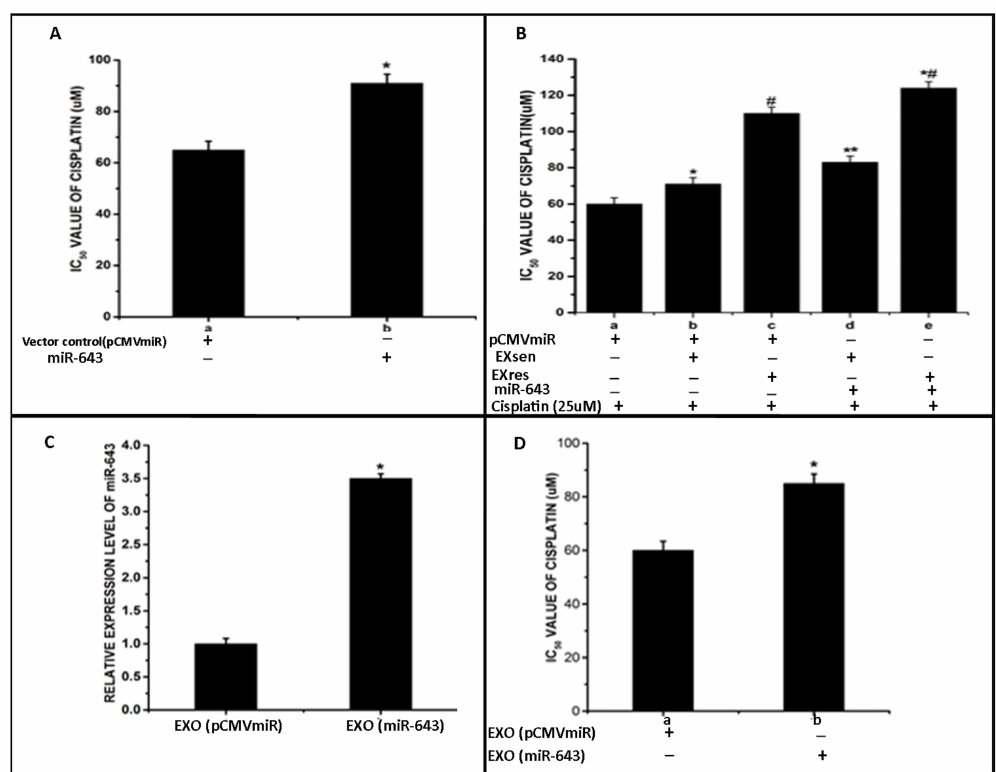
Figure 4. Exosomally conferred miR-643 can modulate cisplatin sensitivity of recipient Hela cells A. XTT viability assay carried out in the presence of miR-643-enriched exosomes and IC 50 was determined. In ( A ), a—Vector alone transfected cells and b—miR-643 overexpressing cells. ( B ) Ectopic expression of miR-643 can augment the resistance conferred by EXsen/EXres. XTT assay was carried out in miR-643 overexpressing cells in presence or absence of EXsen/EXres. In B, a—mock-transfected cells + cisplatin (25 µ M), b—mock-transfected cells + EXsen and cisplatin (25 µ M), c—mock- transfected cells + EXres and cisplatin (25 µ M), d—miR-643 overexpressing cells + EXsen and cisplatin (25 µ M), e—miR-643 overexpressing cells + EXres and cisplatin. ( C ) qRT-PCR analysis of miR-643 levels in exosomes extractedfrom miR-643 overexpressing Hela cells. In ( C ), a—represents exosomes released from vector alone transfected cells, b—exosomes released from miR-643 overexpressing cells. ( D ) Exosomal delivery of miR-643 confers resistance properties to recipient Hela cells against cisplatin. XTTassay was carried out in Hela cells pretreated with 100 µ g of miR-643 enriched exosomes or vector control exosomes In ( D ), a—Hela cells treated with exosomes released from mock-transfected cells (EXO pCMVmiR ), b represents Hela cells treated with exosomes secreted from miR-643 overexpressing cells (EXO miR-643 ). The mean values of two different experiments ± SEM each performed in triplicate are reported in the graph, p < 0.05. * indicates statistical significance when compared to a. # indicates statistical significance when compared to a and b. ** indicates statistical significance when compared to b *# indicates statistical significance when compared to